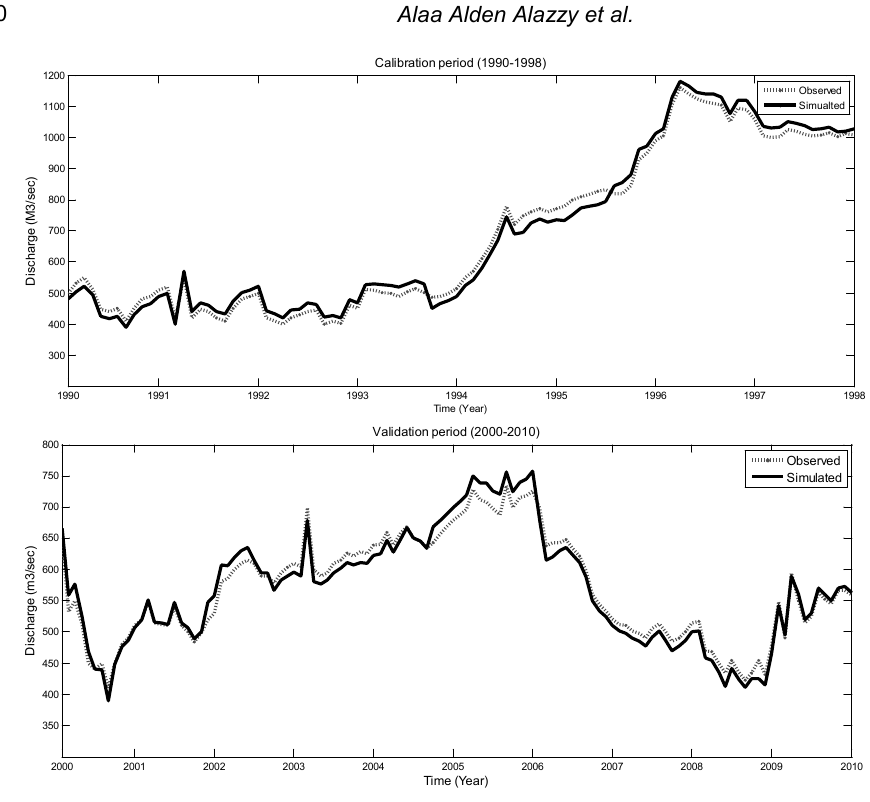
Fig. 3 Calibration and validation for the WEAP